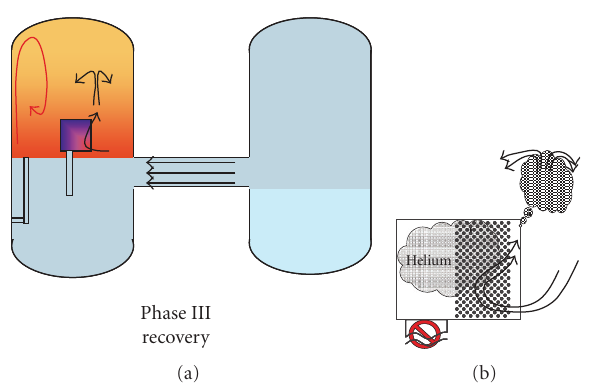
Figure 23: Power removed by the cooler during test ST4 3 compared with ST4 2 (ST4 2 2).